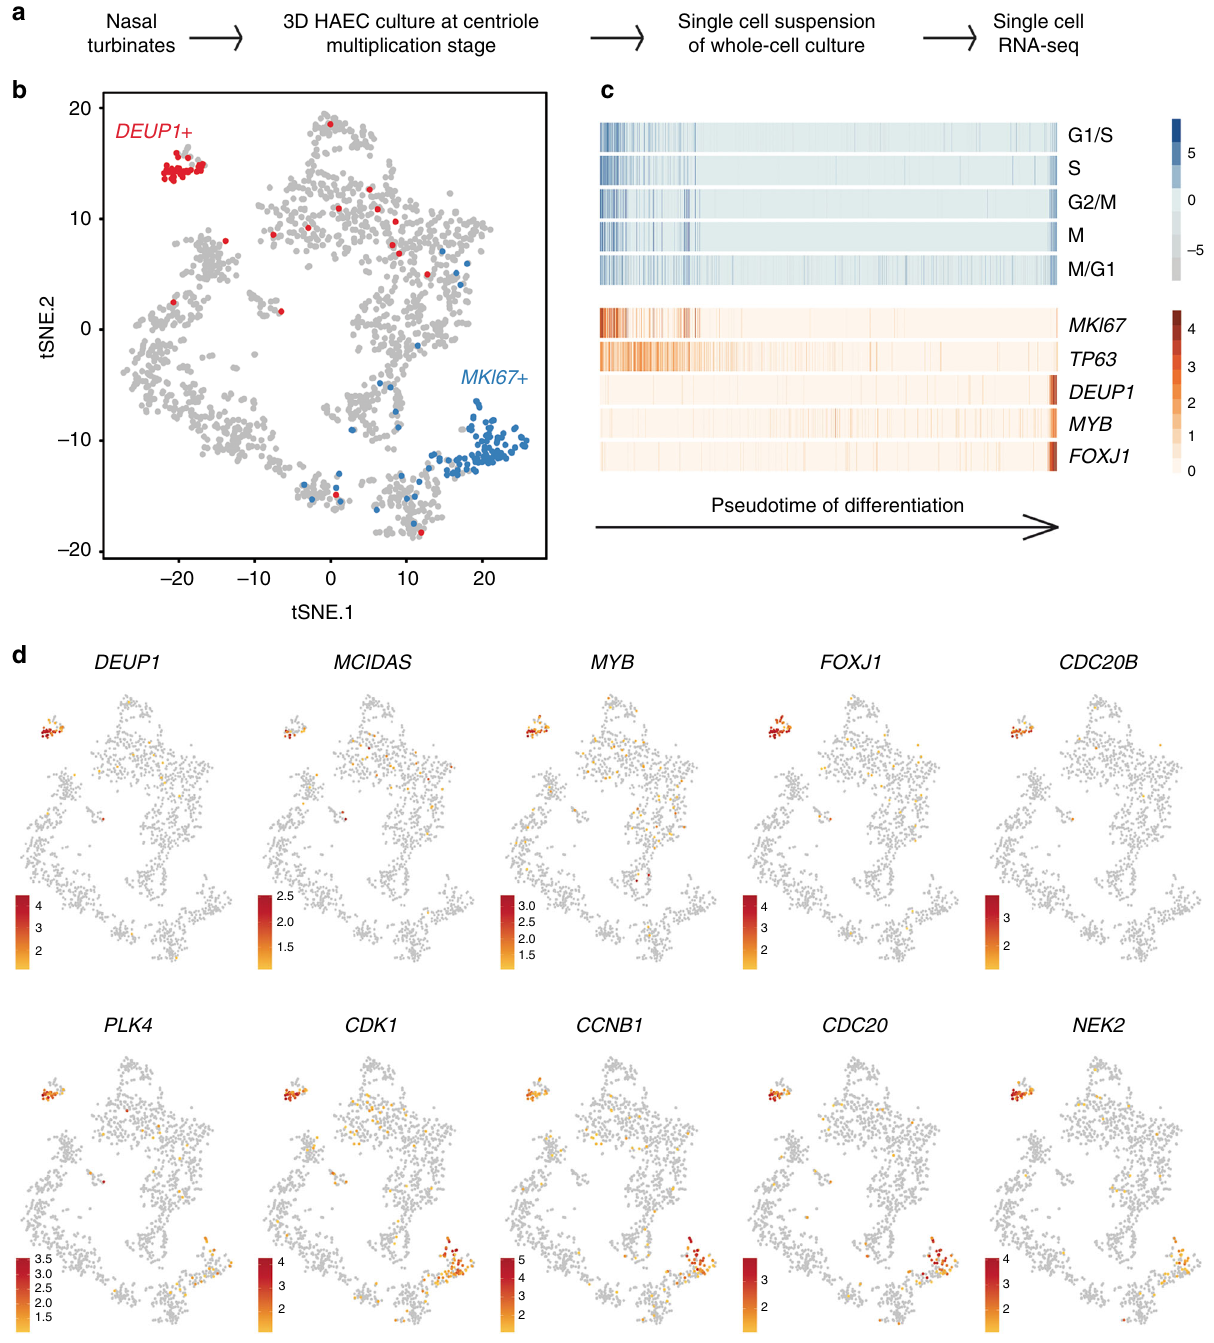
Fig. 1 Single-cell RNA-seq analysis reveals MCC transcriptome at deuterosome stage. a Experimental design of the scRNA-seq experiment. b tSNE plot. Each point is a projection of a unique cell on a 2D space generated by the tSNE algorithm. Blue dots represent MKI67 -positive proliferating cells, and red dots represent DEUP1 -positive cells corresponding to maturing MCCs at deuterosome stage. c Cell cycle-related gene set expression in HAECs measured by scRNA-seq. Cells were ordered along a pseudotime axis, de fi ned with the Monocle2 package. Phase-speci fi c scores are displayed in the top heatmap. Expression of selected genes is displayed in the bottom heatmap. d tSNEs plots for a selection of genes speci fi cally enriched in deuterosome stage cells. Note that CDC20B exhibits the most speci fi c expression among deuterosome marker